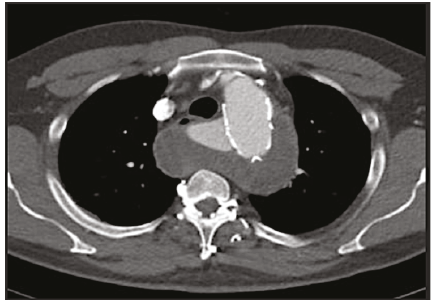
Figure 4: Postoperative axial CT